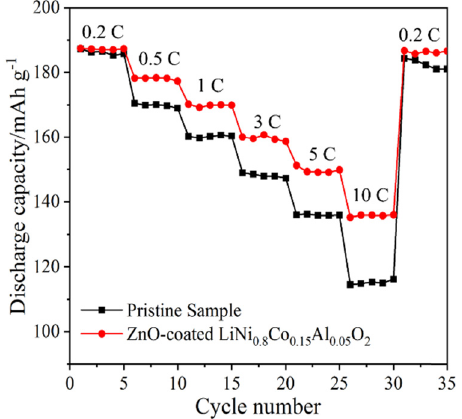
Figure 10: CV curves of pristine and ZnO - coated LiNi 0.8 Co 0.15 Al 0.05 O 2 samples at a scanning rate of 0.1 mV s − 1 in the voltage of 3.0 – 4.3